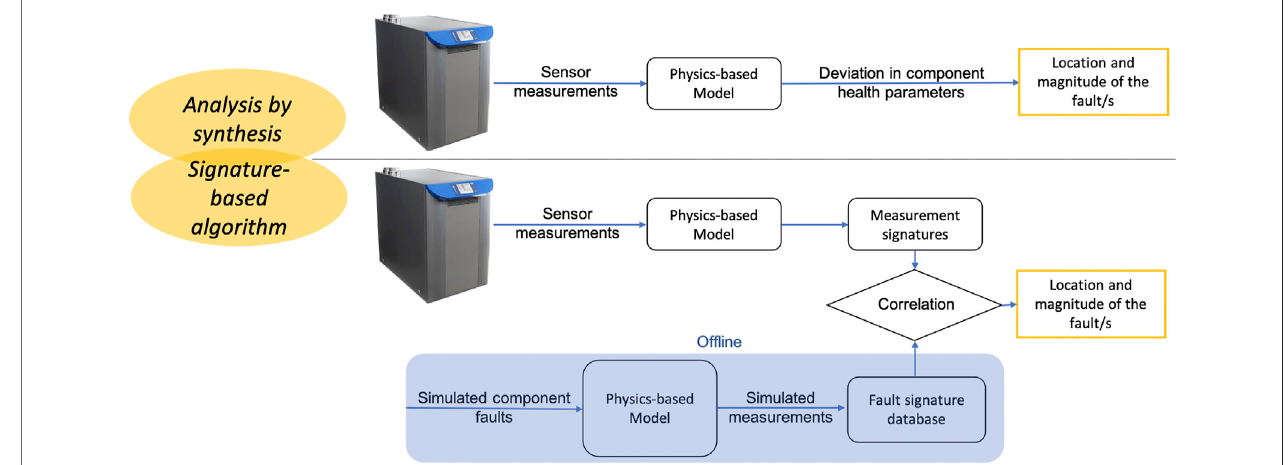
FIGURE 5 | Physics-based